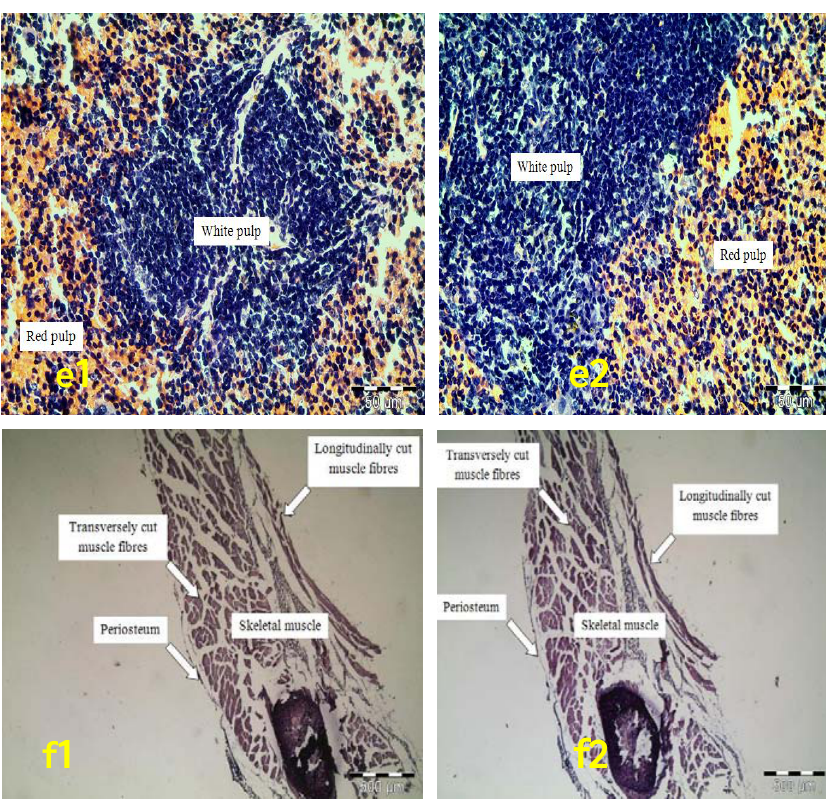
Table 4. Brine shrimp toxicity expressed as LC